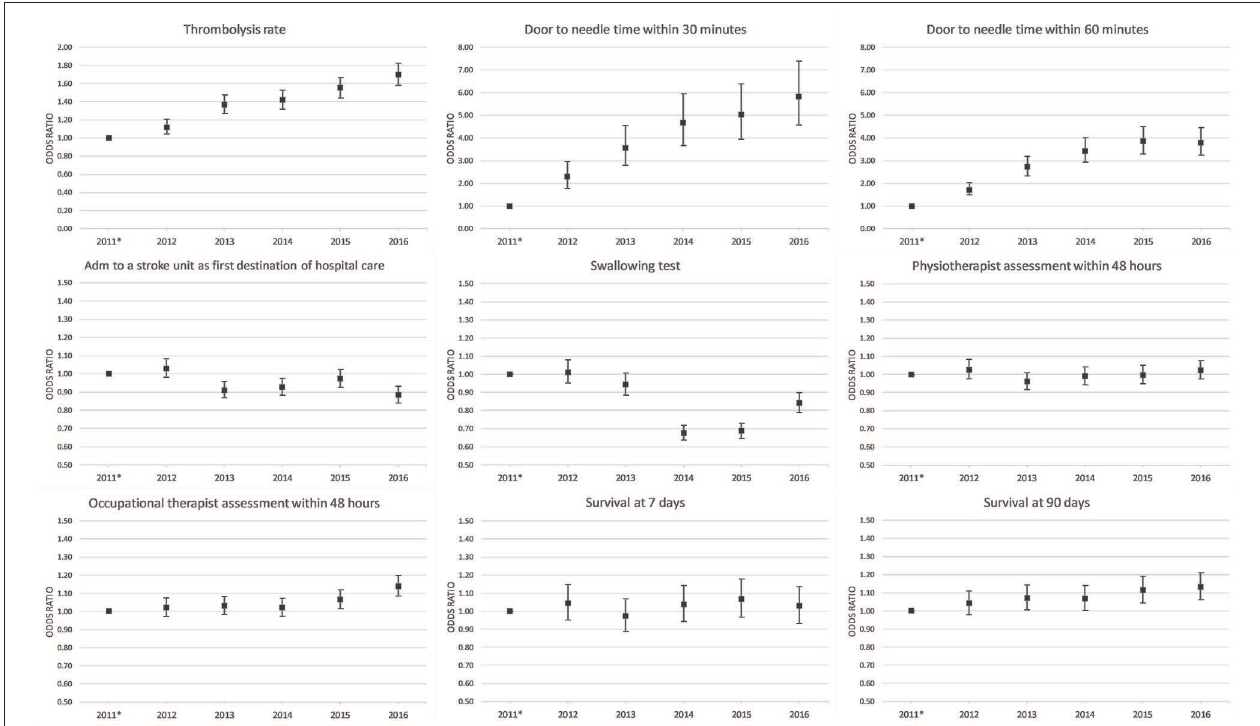
FIGURE 4 | Adjusted analyses of quality-of-care indicators and survival per year. *Reference.